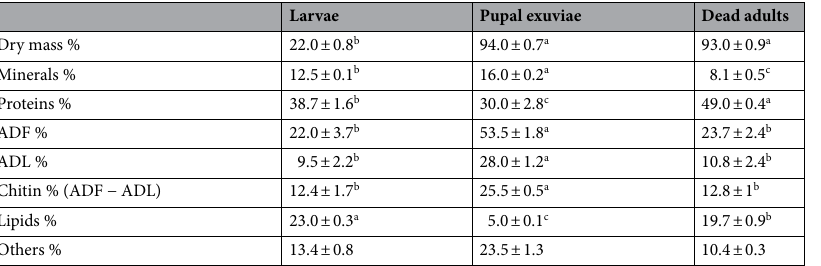
Table 1. Composition of raw H. illucens larvae, pupal exuviae and dead adults used for chitin extraction and chitosan production. Additional components defined as "others" have been calculated by the difference between 100 and the percentage of the other elements, experimentally determined. Data are expressed as mean ± standard deviation. Different letters in a row indicate significant differences among the different samples in the percentage of each component (p < 0.05) (data analysed with one-way ANOVA and Tuckey post-hoc test). ADF acid detergent fibre, ADL acid detergent